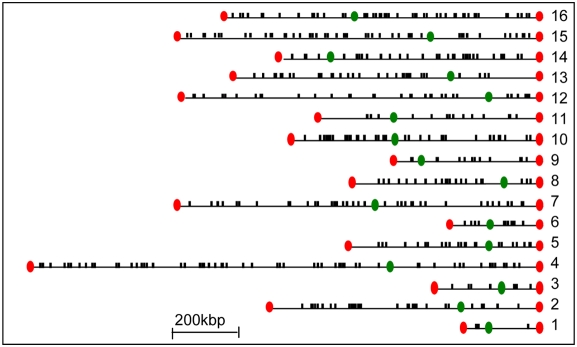
Chromosomal distribution of the 500 coding regions with the highest relative exchange (relative exchange>0.7).